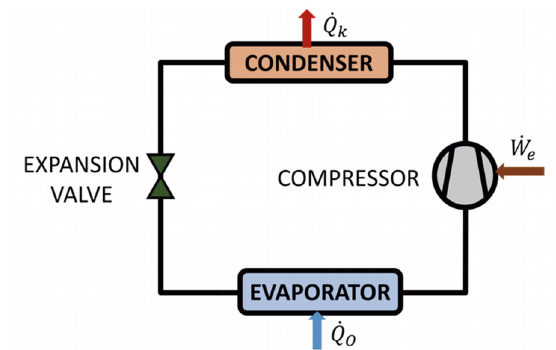
Figure 5. Schematic of the cooling